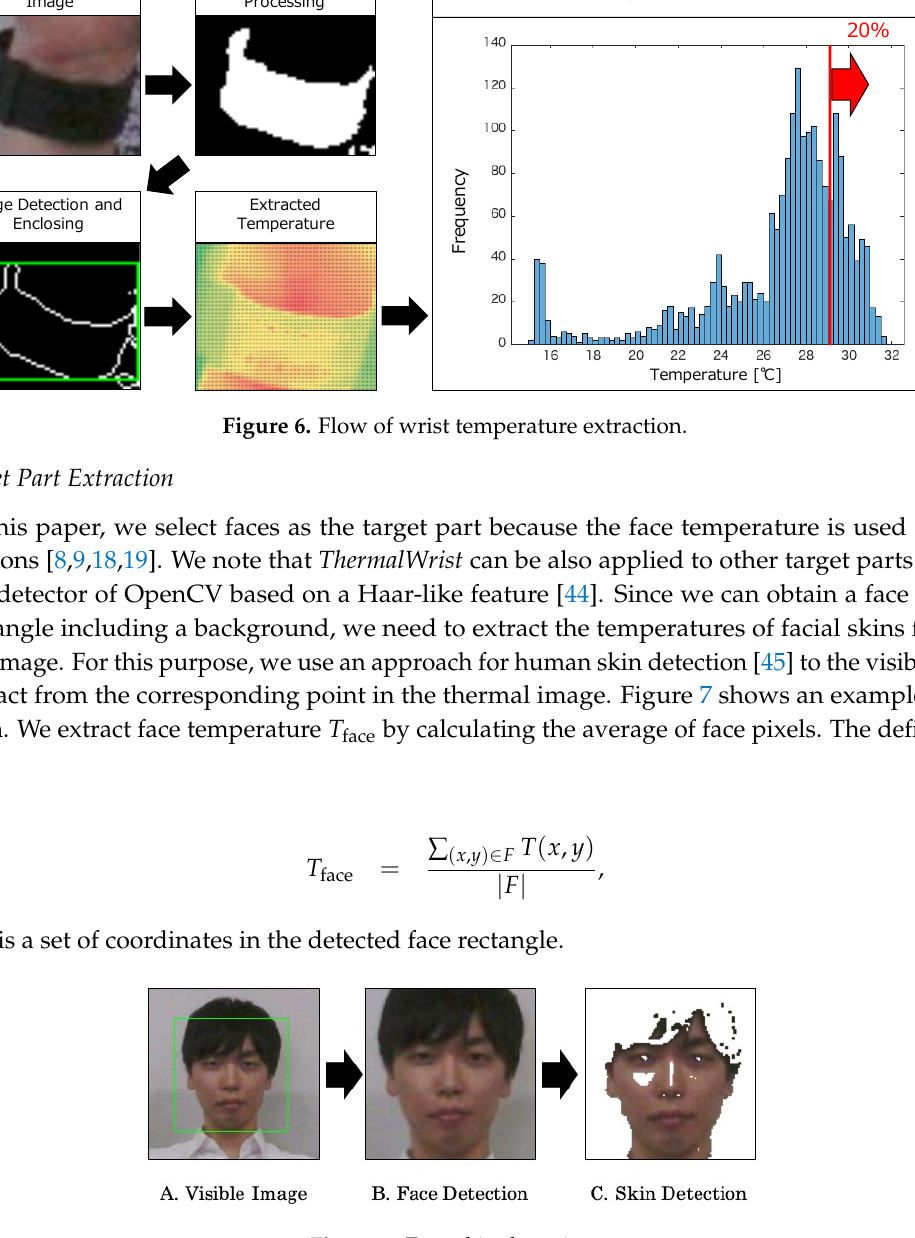
Figure 7. Face skin